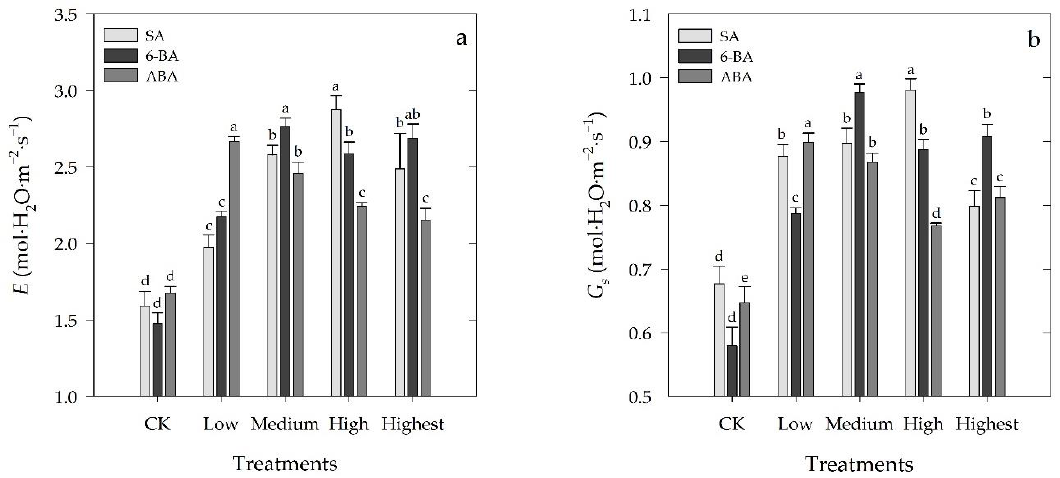
Figure 3. Effects of different concentrations of SA, 6-BA or ABA on the transpiration rate (E, ( a )) and stomatal conductance (G s , ( b )) of Rosa hybrida ‘Carolla’. CK: distilled water. Low: 0.5 mmol ·L −1 SA, 10 μmol ·L −1 6- BA, 37.5 μmol ·L −1 ABA; medium: 1.0 mmol·L −1 SA, 20 μmol ·L −1 6- BA, 75 μmol ·L −1 ABA; high: 1.5 mmol·L −1 SA, 30 μmol ·L −1 6- BA, 112.5 μmol ·L −1 ABA; highest: 2.0 mmol·L −1 SA, 50 μmol ·L −1 6- BA, 187.5 μmol ·L −1 ABA; Vertical bars denote standard errors ( n = 10). The values are described as the means ± SD; different letters denote significant differences ( p < 0.05), according to Duncan’s